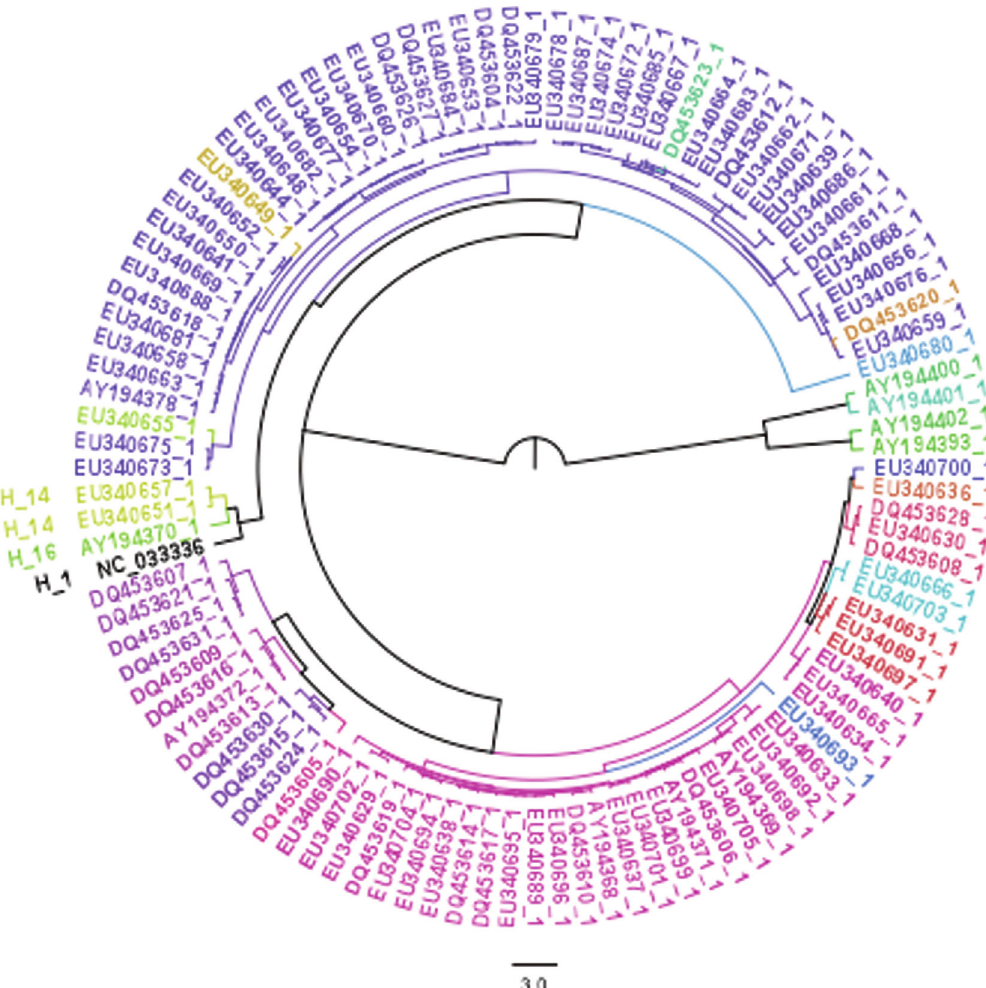
Figure 6 - Coalescent-based COI tree. The placement of the COI sequence from the individual described here (H_1, NC_033336) is consistent with our findings using the haplotype network and the DNA Surveillance identification of Brazilian parrots. We also marked the three closest sequences from haplotypes H_14 and